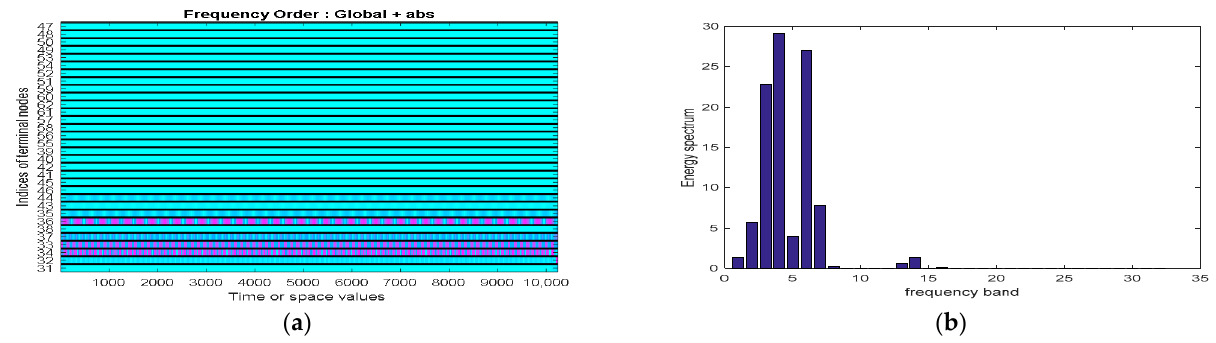
Figure 6. ( a ) sym20 wavelet tree termination node; ( b ) energy spectrum of sym20 wavelet decomposition.